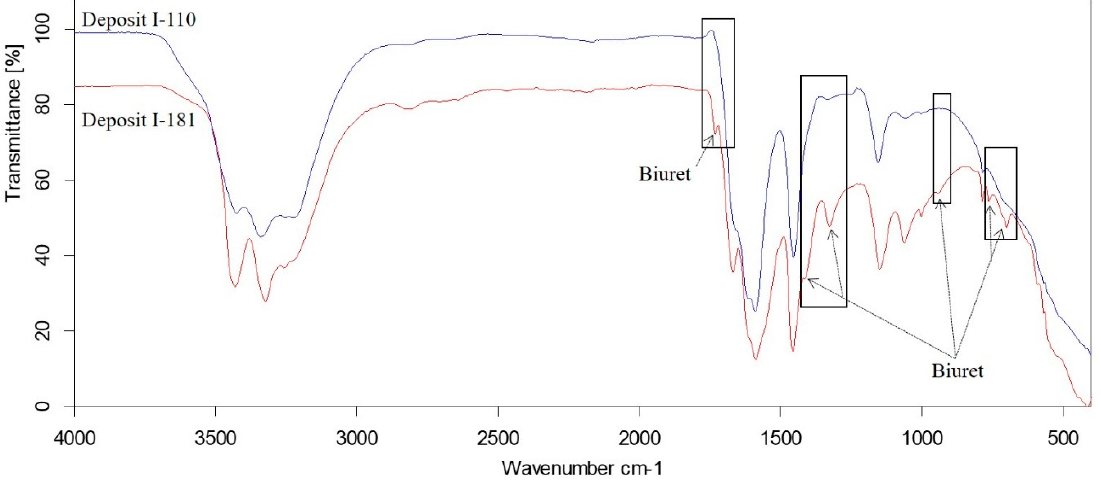
Figure 6. FTIR spectra of deposit I-110 and I-181 obtained at T air = 200 °C (T sample = 110 °C) and T air = 250 (T sample = 181 °C), correspondingly.